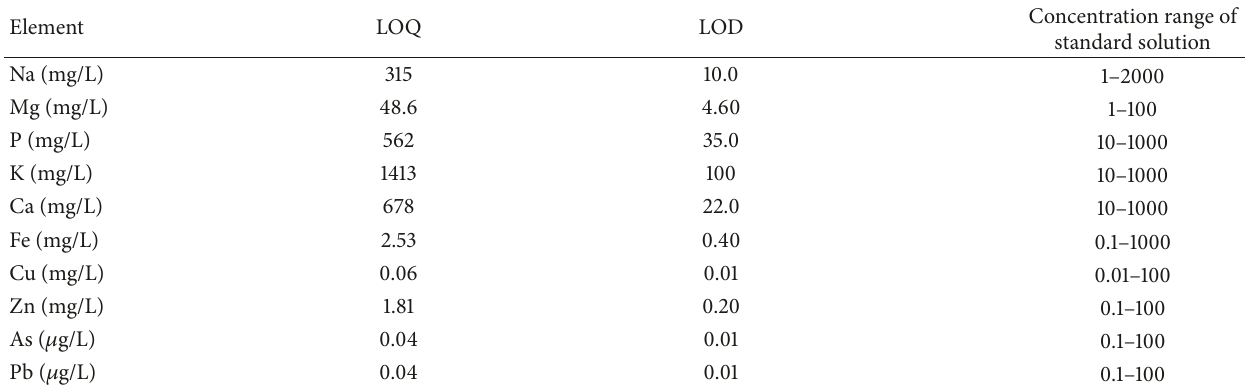
Table 2: Quantification and detection limits.